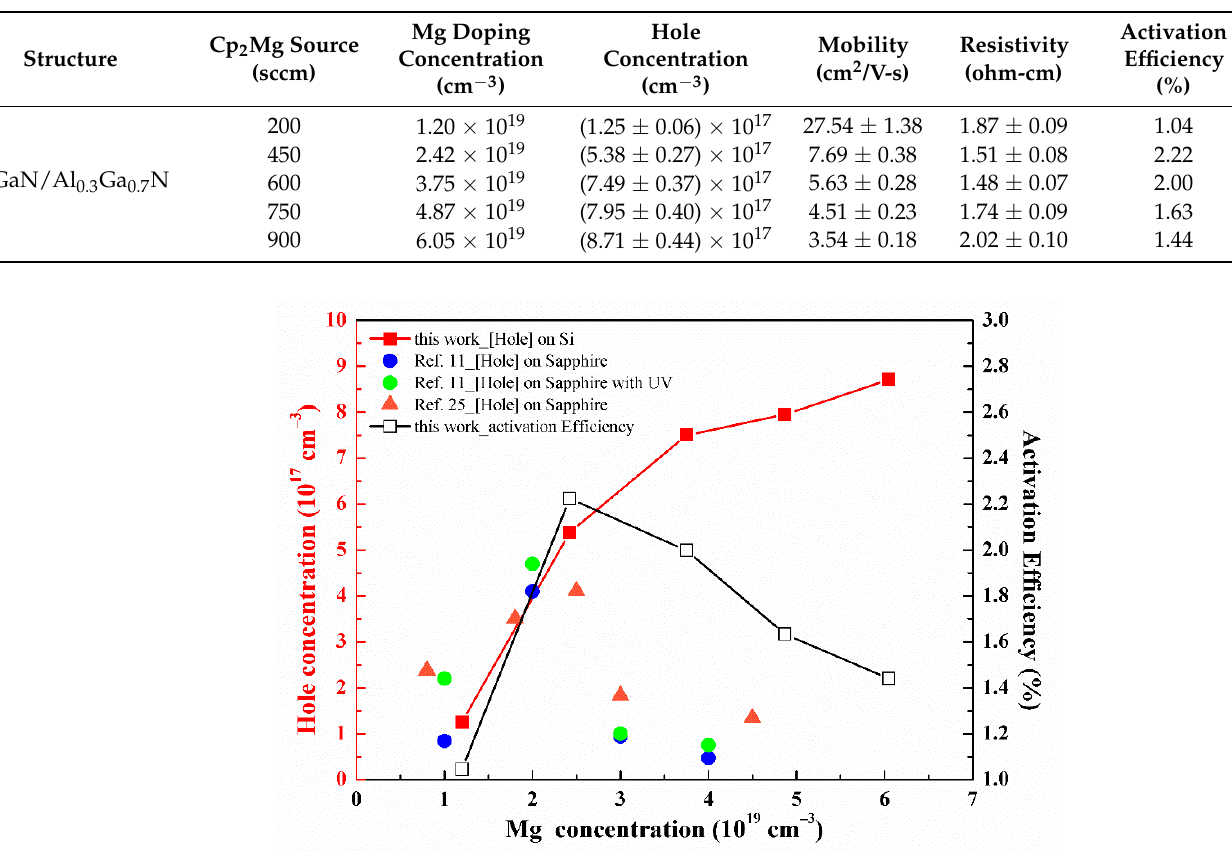
Figure 2. The hole concentration (red solid squares) and activation efficiency (open squares) of p-GaN:Mg layer as a function of the Mg doping concentration. The results from references [11,25] are also plotted for comparison, as shown by blue circles, green circles, and orange triangles.